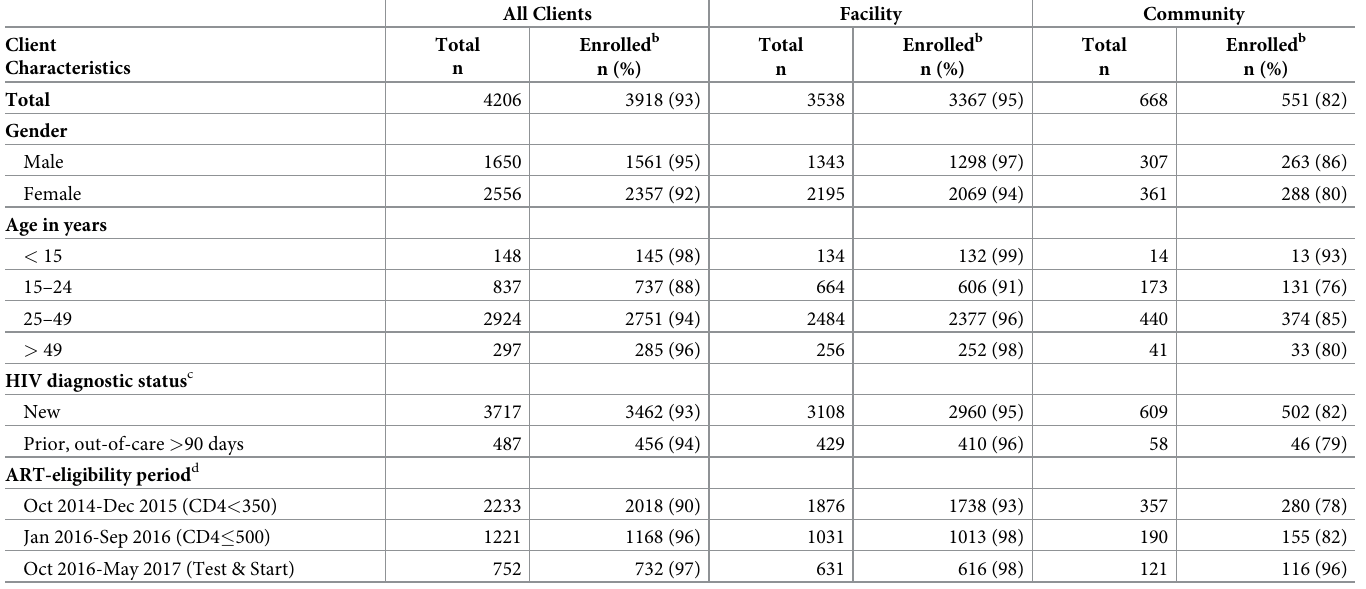
Table 3. Enrollment in HIV care within 90 days of LCM program consent, by setting of HIV diagnosis and client characteristics, Bukoba Combination Prevention Evaluation, Bukoba Tanzania, 2014–2017. a . All